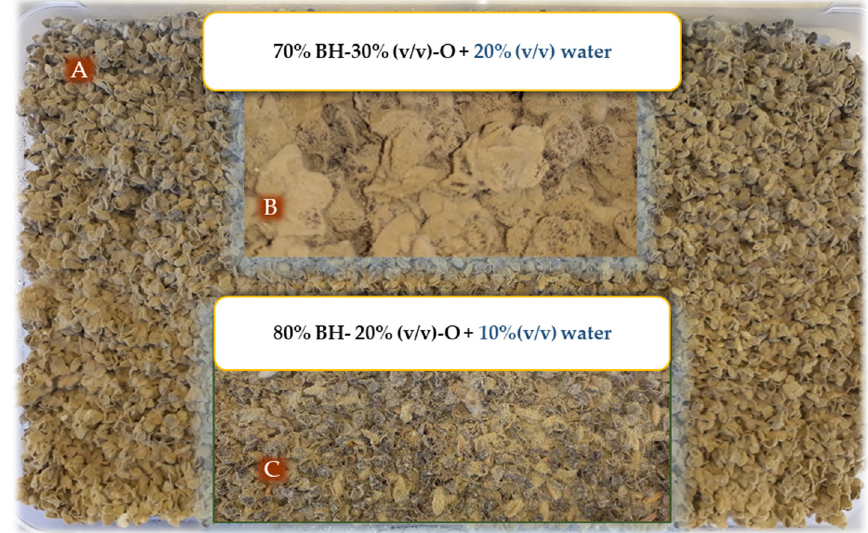
Figure 3. Mass production of P. variotii spores at a proportion of 70% + 30% buckwheat husk and oats, respectively, + 20% water ( A,B ) and at 80% + 20% with 10% water ( C ). Table 1. E ff ects of solid media on mass multiplication of P. variotii at varying substrates percentages ( v / v ) and water contents ( v / v ). Treatments % ( v / v )